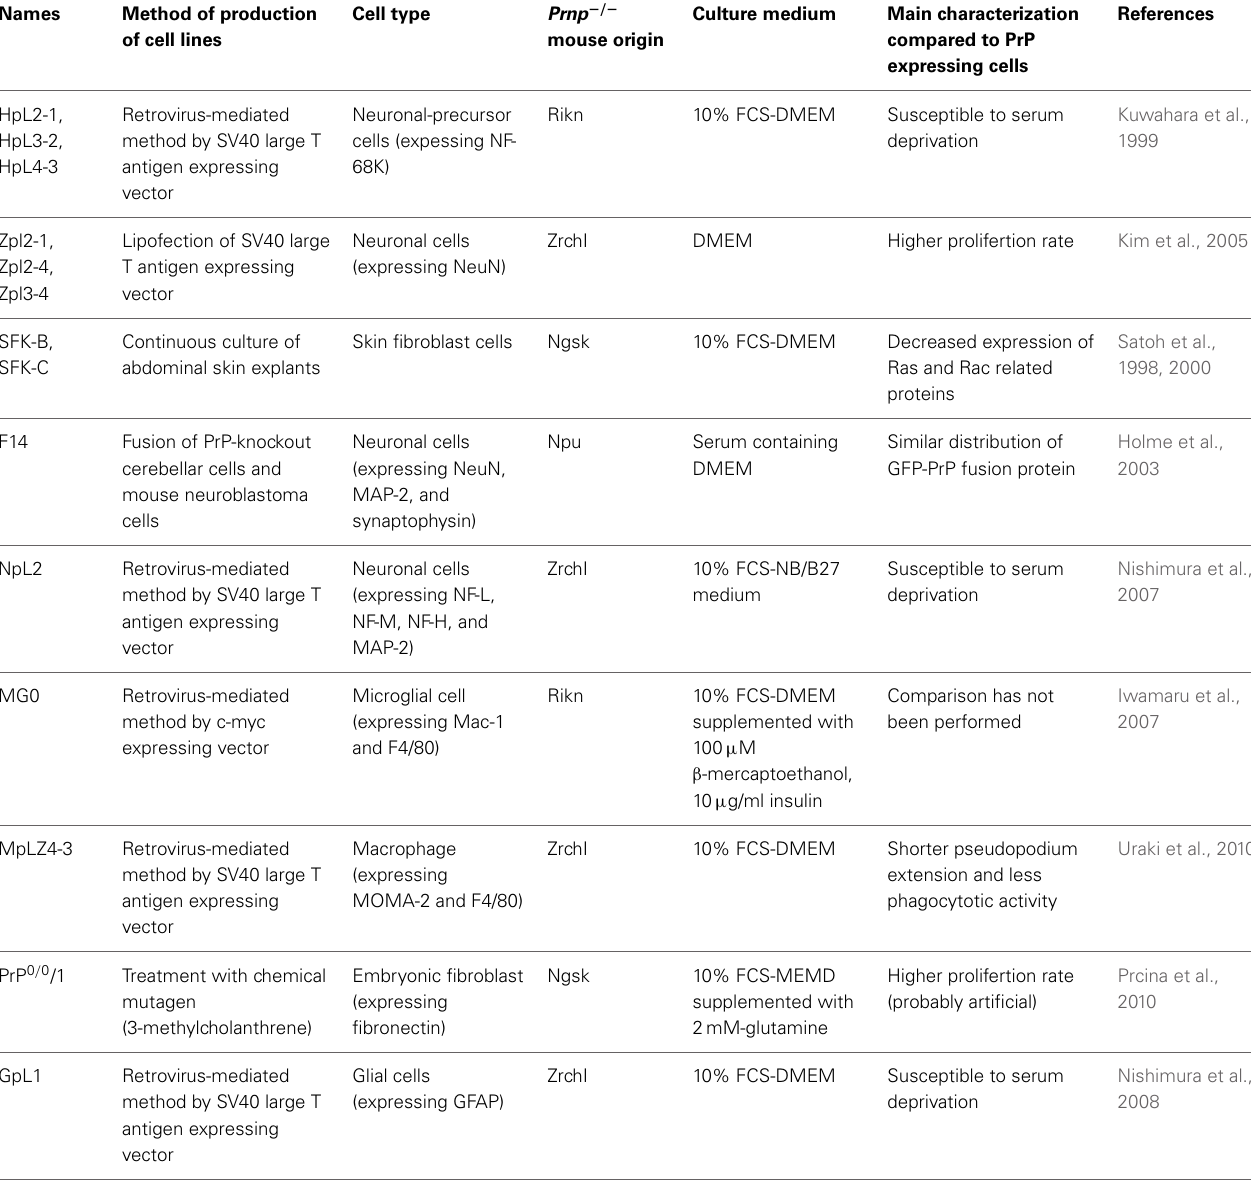
Table 1 | Prnp − / − cell lines and their